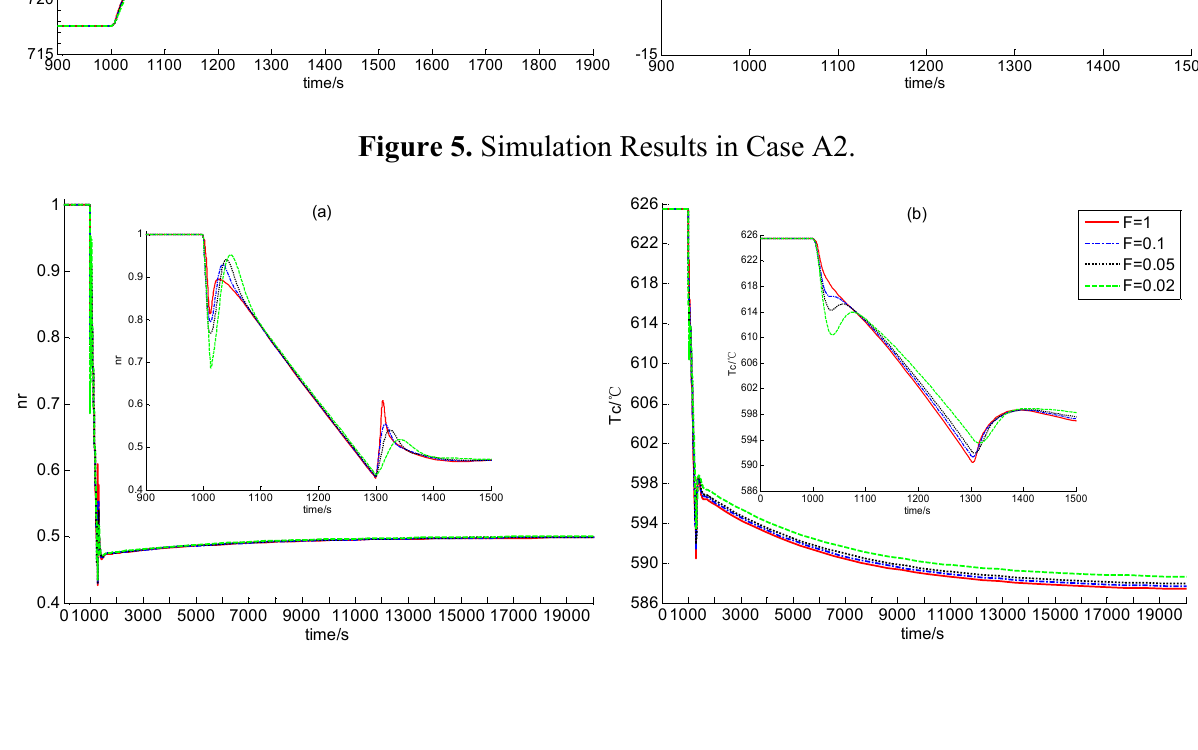
Figure 5. Simulation Results in Case